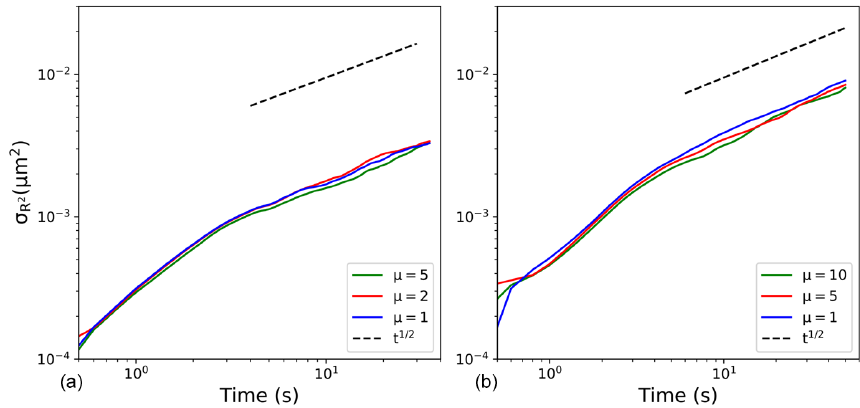
Figure 5. Evolutions of the radius squared standard deviation ( σ R 2 ) for real DNS with different multiplicity parameters. Panels (a, b) correspond to 64 3 / 128 3 real DNS ( L = 6 . 4 / 12 . 8cm). Colors represent different multiplicities as marked inside each